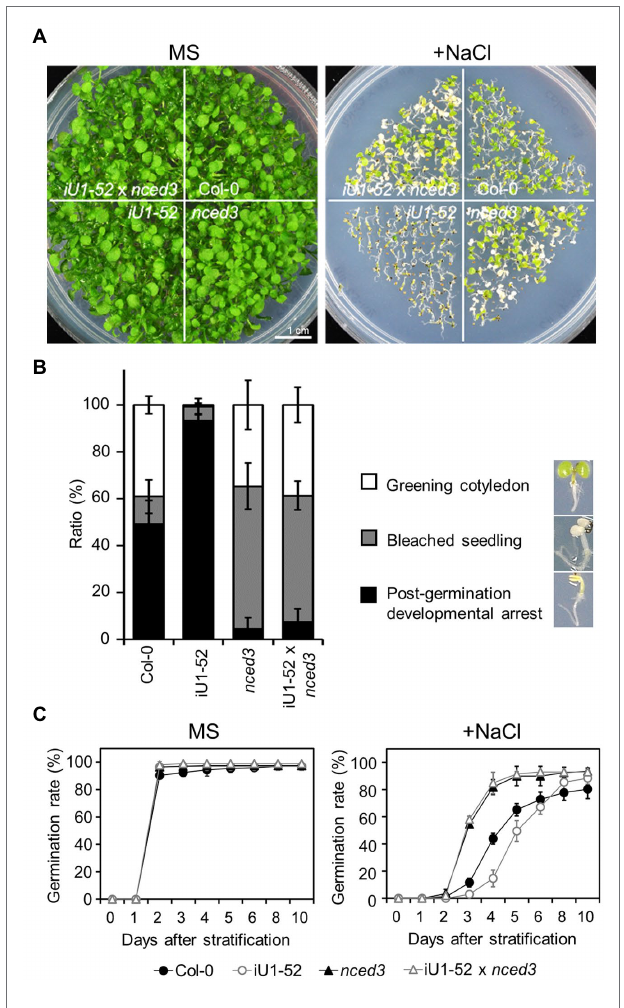
FIGURE 7 | The nced3 mutant allele abrogates salt hypersensitivity in iU1 plants (A) . Comparison of the seedling phenotypes. The seedlings were grown on agar plates supplemented with or without NaCl (200 mM) for 14 days. (B) Phenotypic quantification derived from (A) . (C) Seed germination rate. The seeds were sown on agar plates supplemented with or without 200 mM NaCl. Data are presented as the means ± SD of at least three biological replicates. Each replicate contained ~66